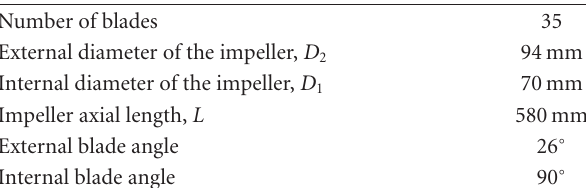
Table 1: Specifications of the studied